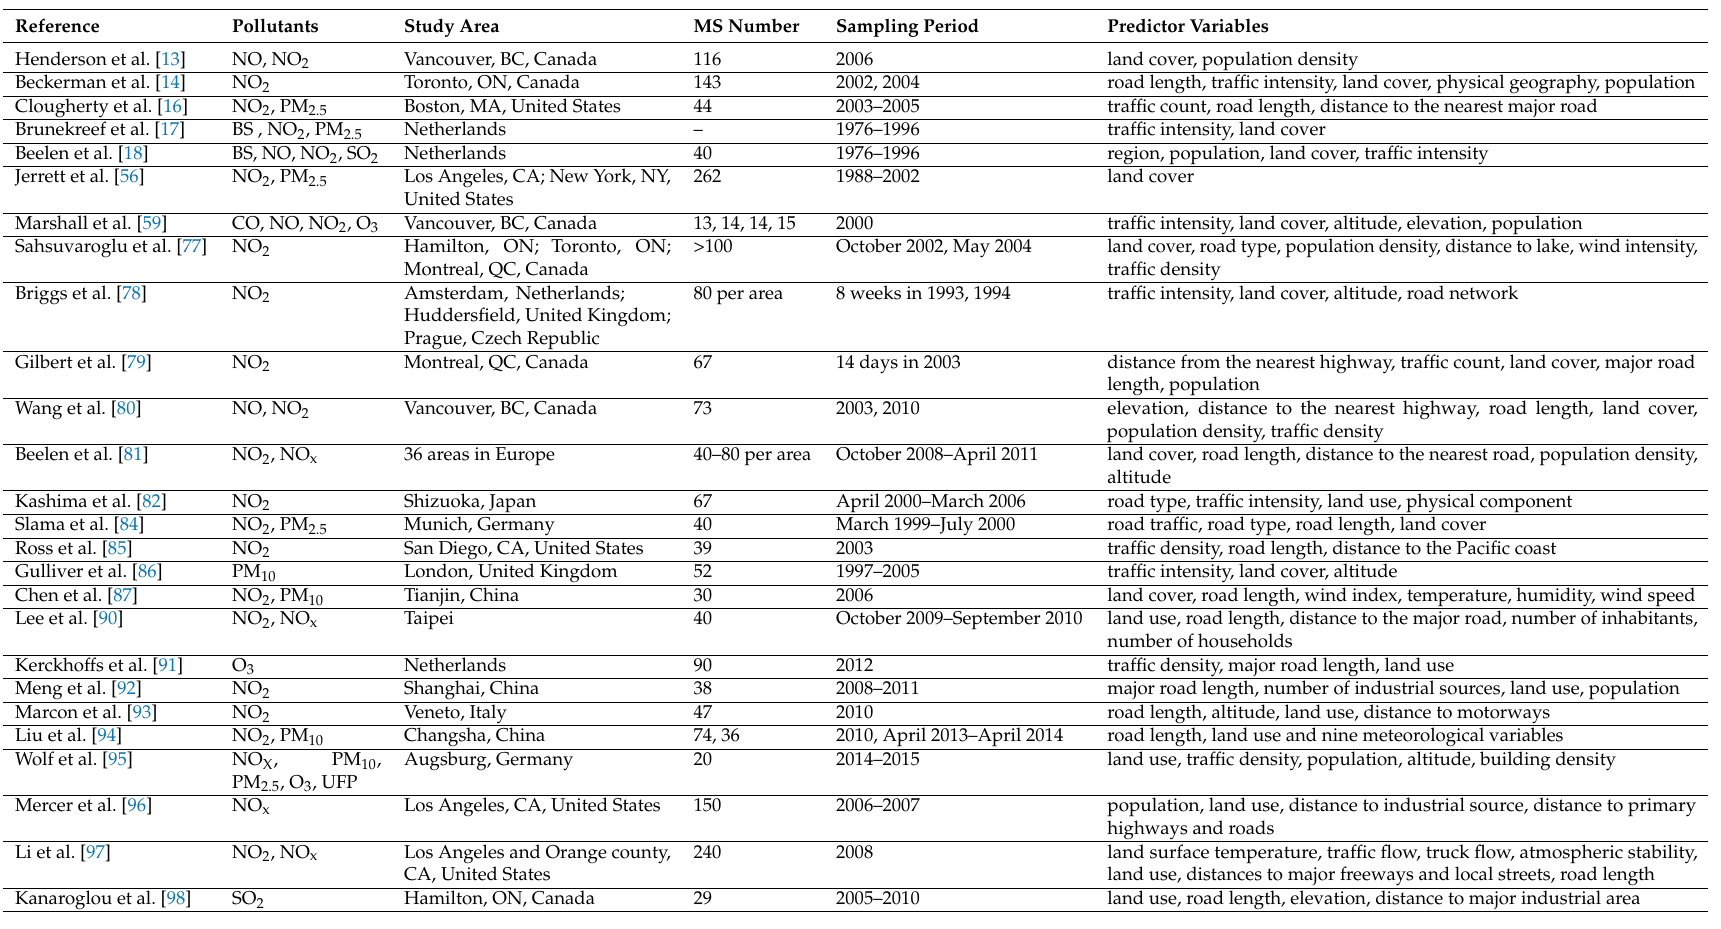
Table 2. Land-use regression